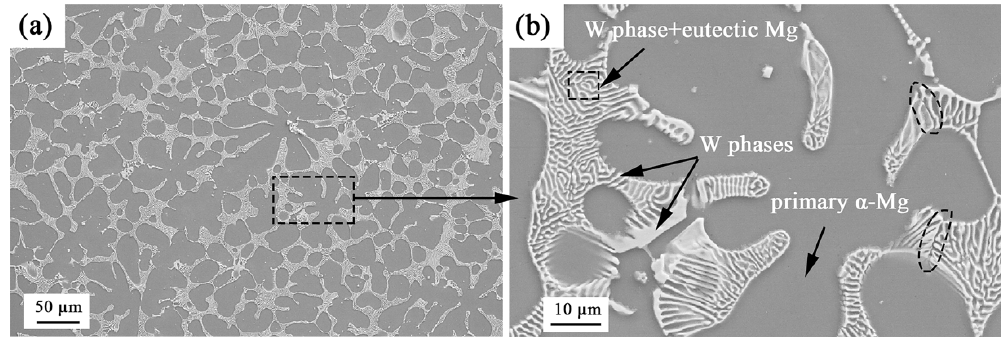
Figure 2. SEM microstructure of the as-cast Mg–10Zn–6.8Gd–4Y alloy: ( a ) low magnification; ( b ) high magnification.